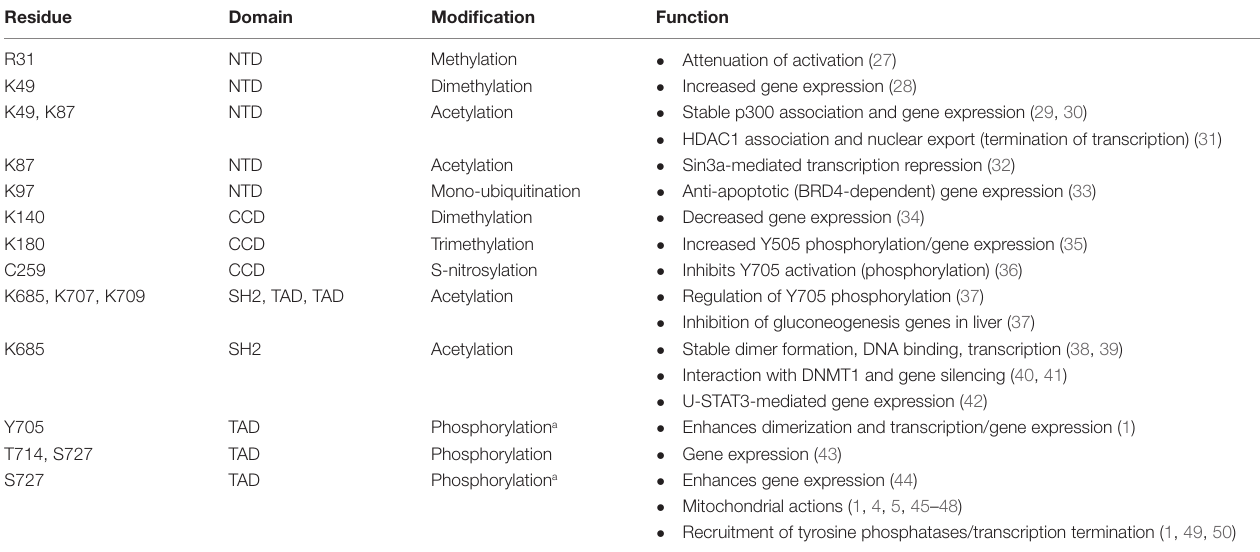
TABLe 1 | Posttranslational modifications of